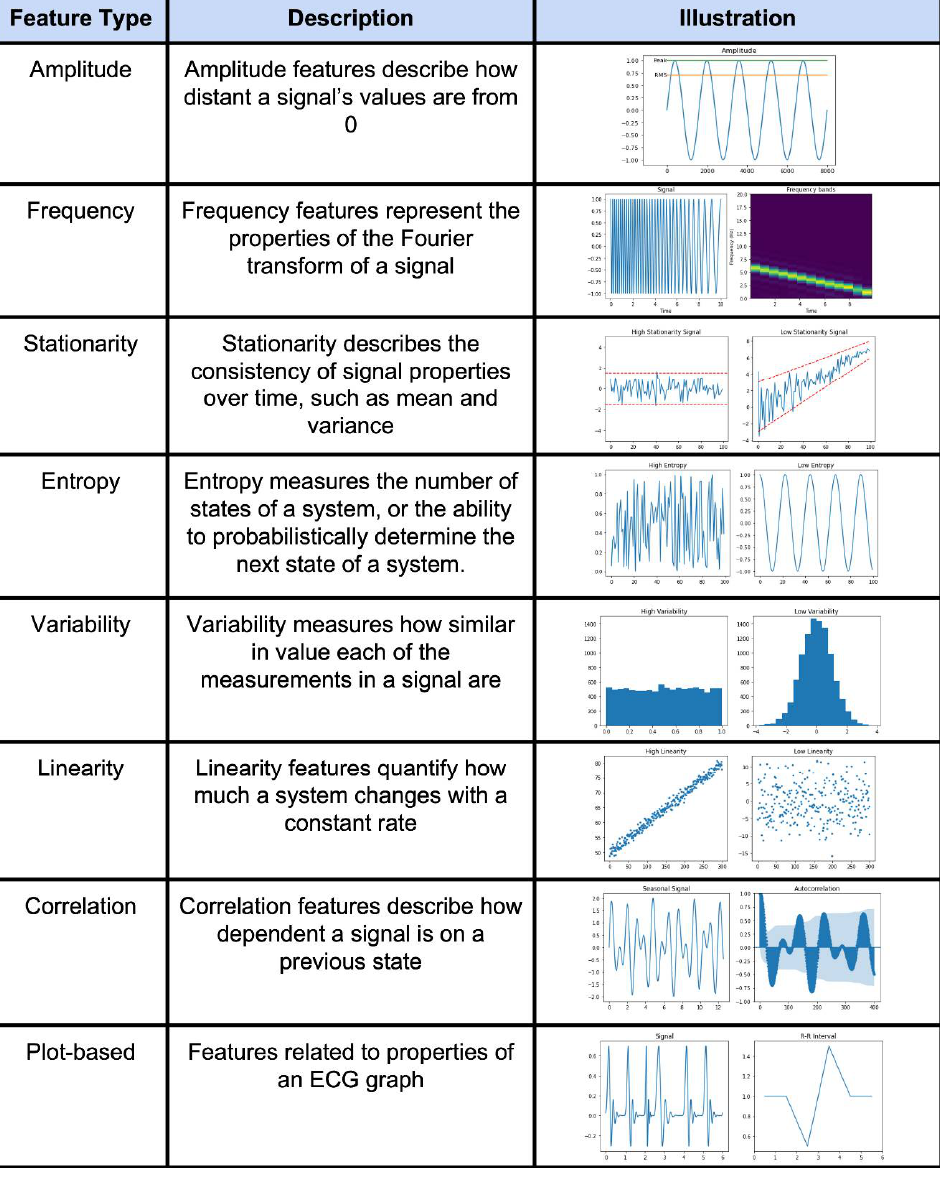
Figure 4. Illustration of different types of feature engineering techniques